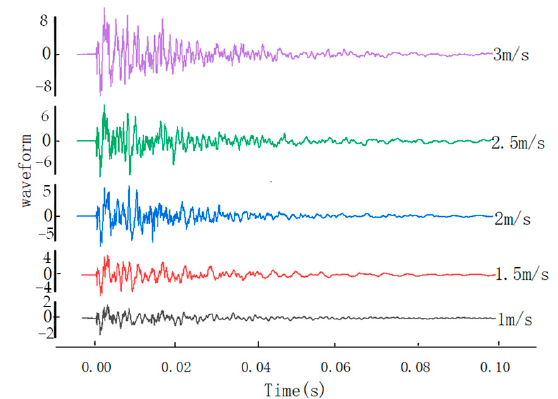
Figure 18. Voltage waveforms under different impact speeds.